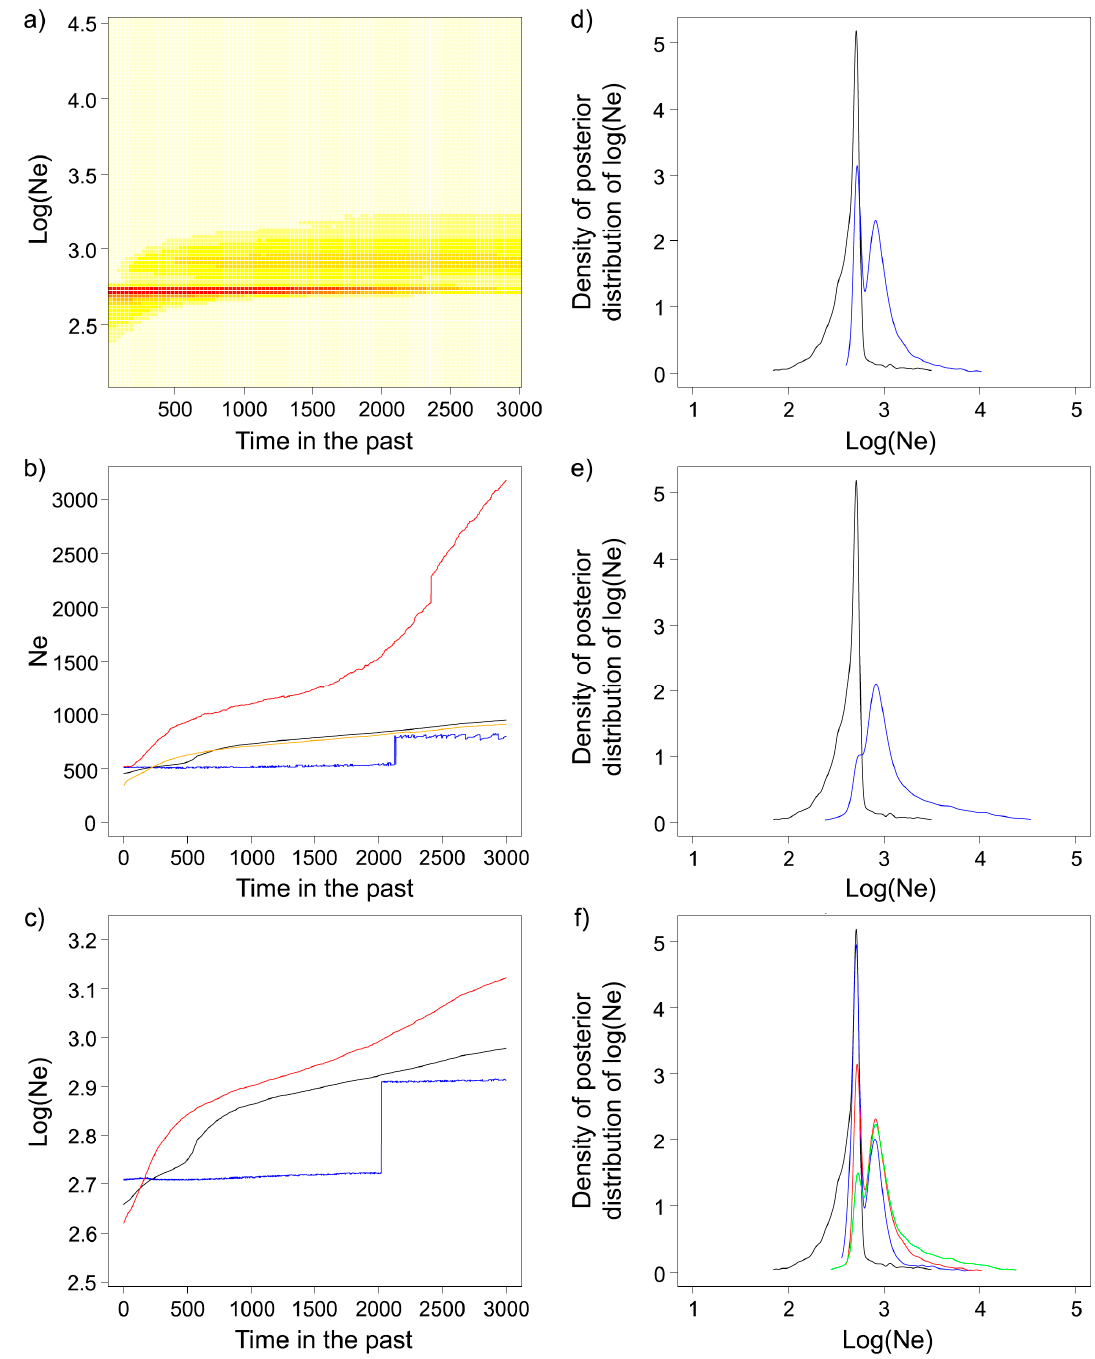
Figure 6. V ar E ff inference of demographic history over the last 3000 generations based on the APNR data set. ( a ) Joint posterior distribution for logN e ( y -axis) over time in generations ( x -axis); ( b ) and ( c ) mean (red), median (black), mode (blue) and harmonic mean (orange) of N e estimates in linear and logarithmic scales, respectively; ( d ), ( e ) and ( f ) densities of the posterior distributions of logN e for the present and at different times in the past. ( d ) logN e estimates for the present (black) and 1500 generations ago (blue), ( e ) logN e estimates for the present (black) and 3000 generations ago (blue) and ( f ) logN e estimates for the present (black) and 500 (blue), 1500 (red) and 2500 (green) generations ago. The sign and Wilcoxon’s signed rank tests in B ottleneck under the SMM or TPM, except those using the latter model with 78% single-step mutations (which were not significant at α = 0.05),